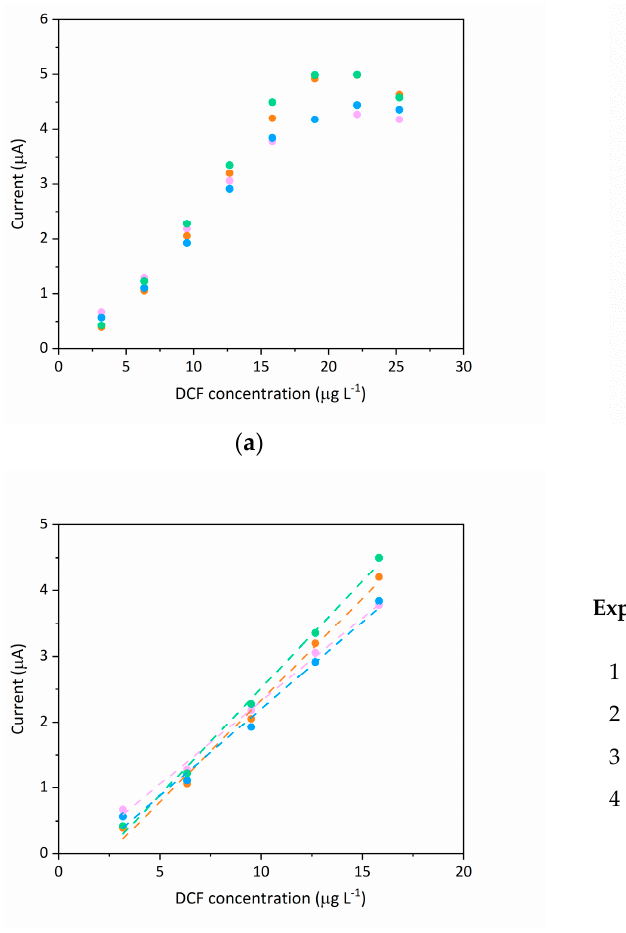
the aGCE surface (3–16 µ g L − 1 DCF; PB 5 × 10 − 2 mol L − 1 pH